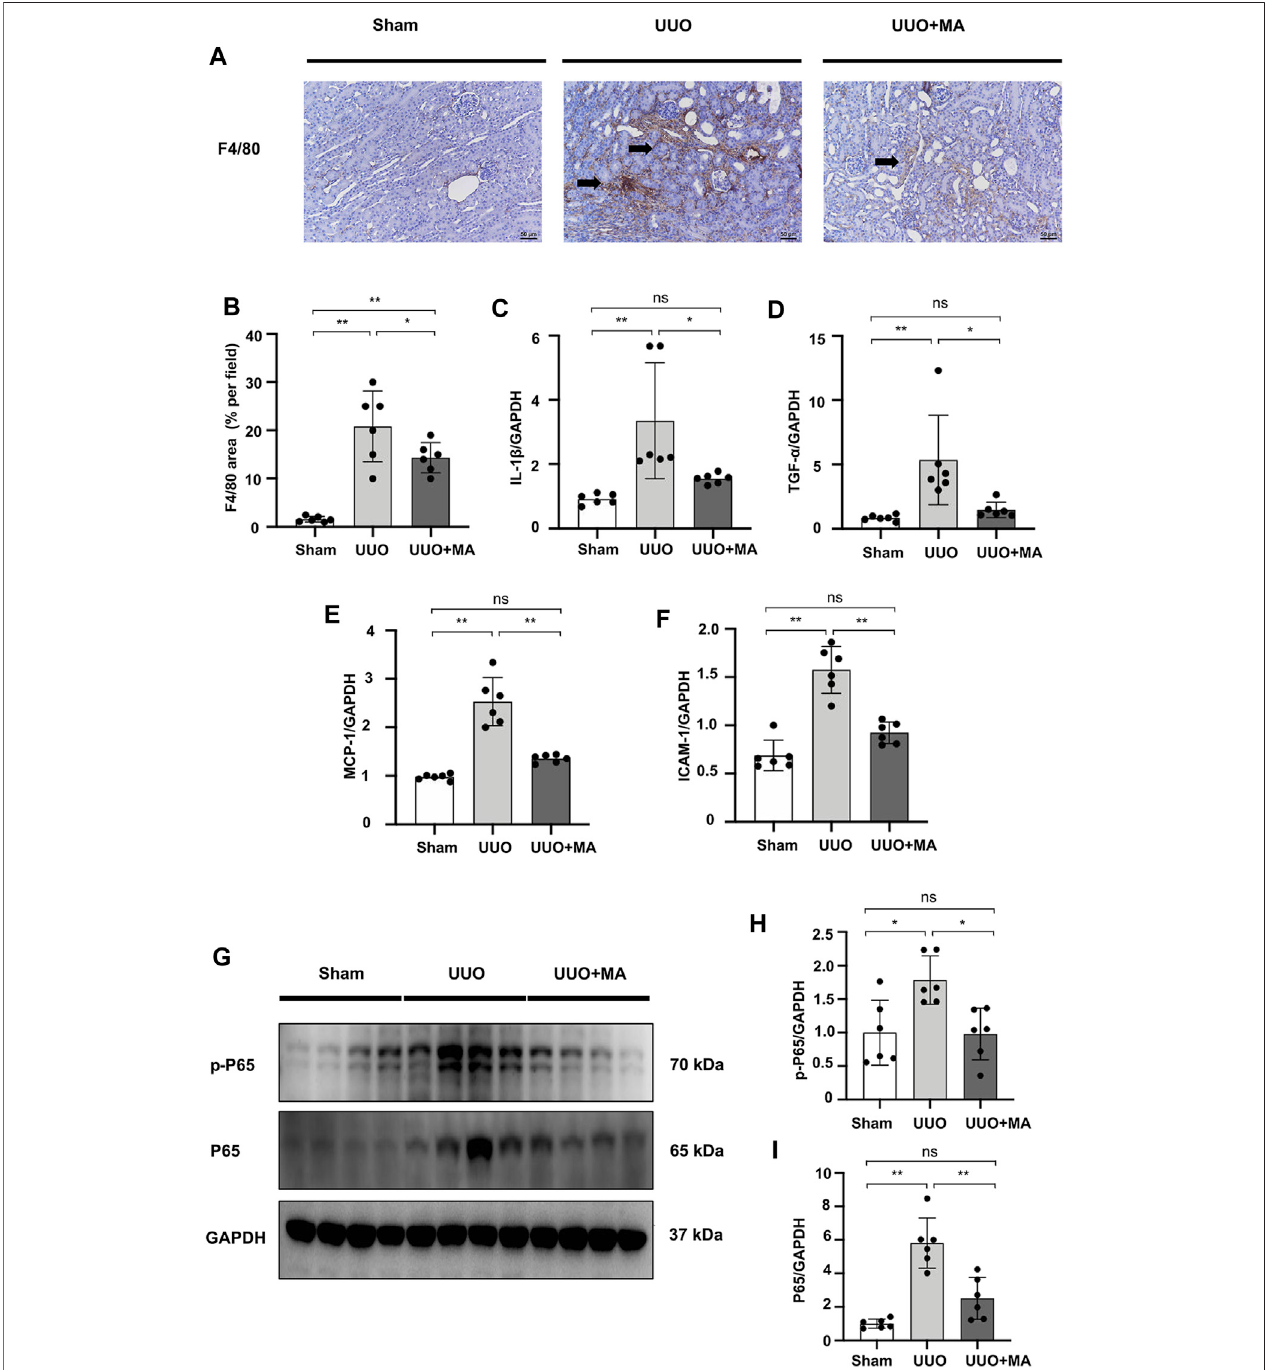
FIGURE8| MAamelioratesrenalmacrophagein fi ltrationandin fl ammationinUUOmicemodelassociatedwiththesuppressionofNF- κ Bsignaling. (A) Expression of F4/80 in kidneys was detected by immunohistochemistry with positive areas indicated by black arrows. Original magni fi cation (cid:1) × 20. Bar (cid:1) 50 μ m. (C – F) mRNA expression levels of IL-1 β , TNF- α , MCP-1 and ICAM-1 were evaluated in UUO mice detected by RT-PCR. Results were normalized to GAPDH expression. Statistical signi fi cance was presented as the mean ± SD, n (cid:1) 6. * p < 0.05, ** p < 0.01, ns: no signi fi cance. (G) The protein levels of p-P65, P65 were detected by western blot andquanti fi edbydensitometry.(B,H,I)Statisticalsigni fi cancewaspresented asthemean ± SD, n (cid:1) 6.* p < 0.05,** p < 0.01,ns:nosigni fi cance.MA,maslinicacid;UUO, unilateral ureteral obstruction; RT-PCR, Real-Time PCR.